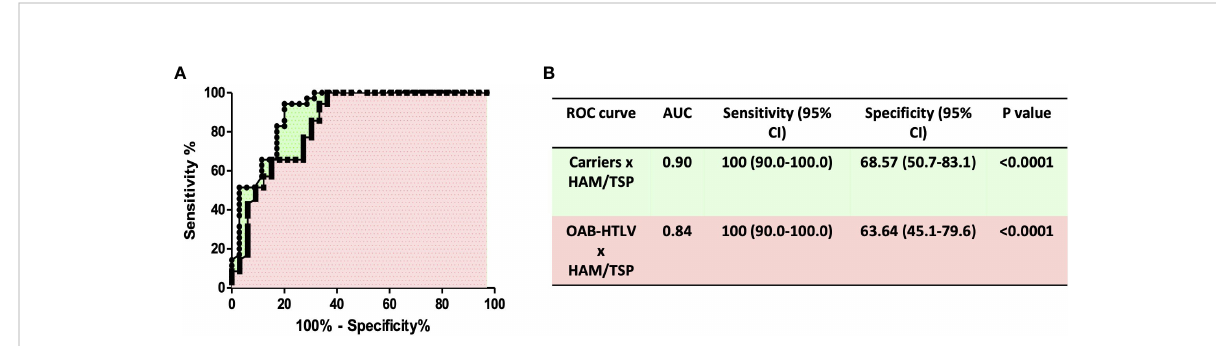
FIGURE 2 ROC curve analysis of MMP-9 levels distinguishes HAM/TSP patients from HTLV-1 carriers and OAB-HTLV-infected individuals . (A) ROC curves were built based on MMP-9 levels in PBMC supernatants from HTLV-1 carriers, OAB-HTLV-infected and HAM/TSP patients. (B) ROC curve sensitivity and speci fi city estimations with 95% con fi dence intervals (CI), as well as Area Under Curve (AUC) values, corresponding P values, and selected cut-off values.